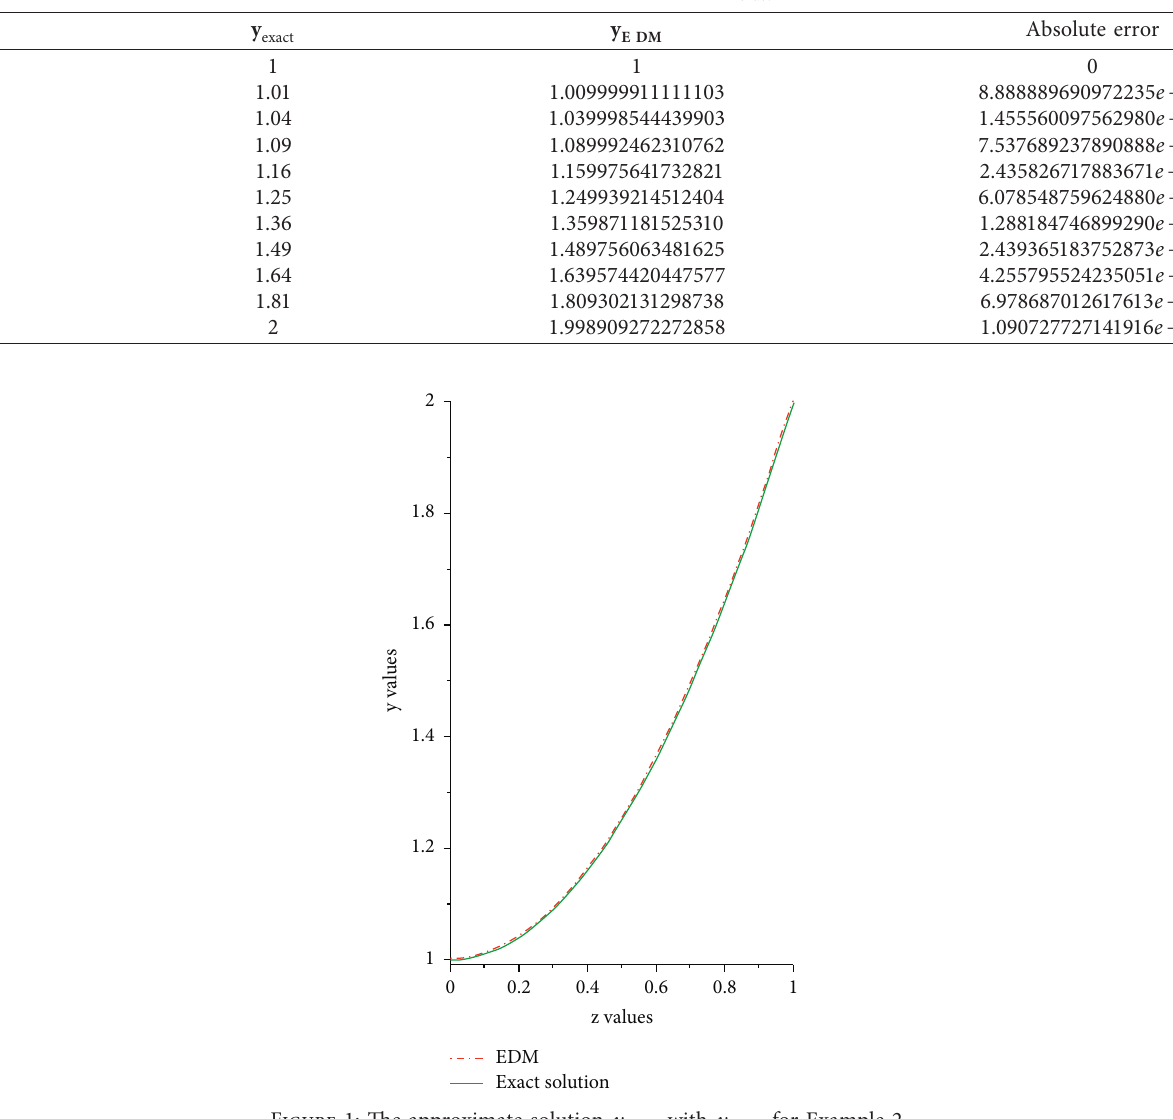
Table 2: The approximation numerical y